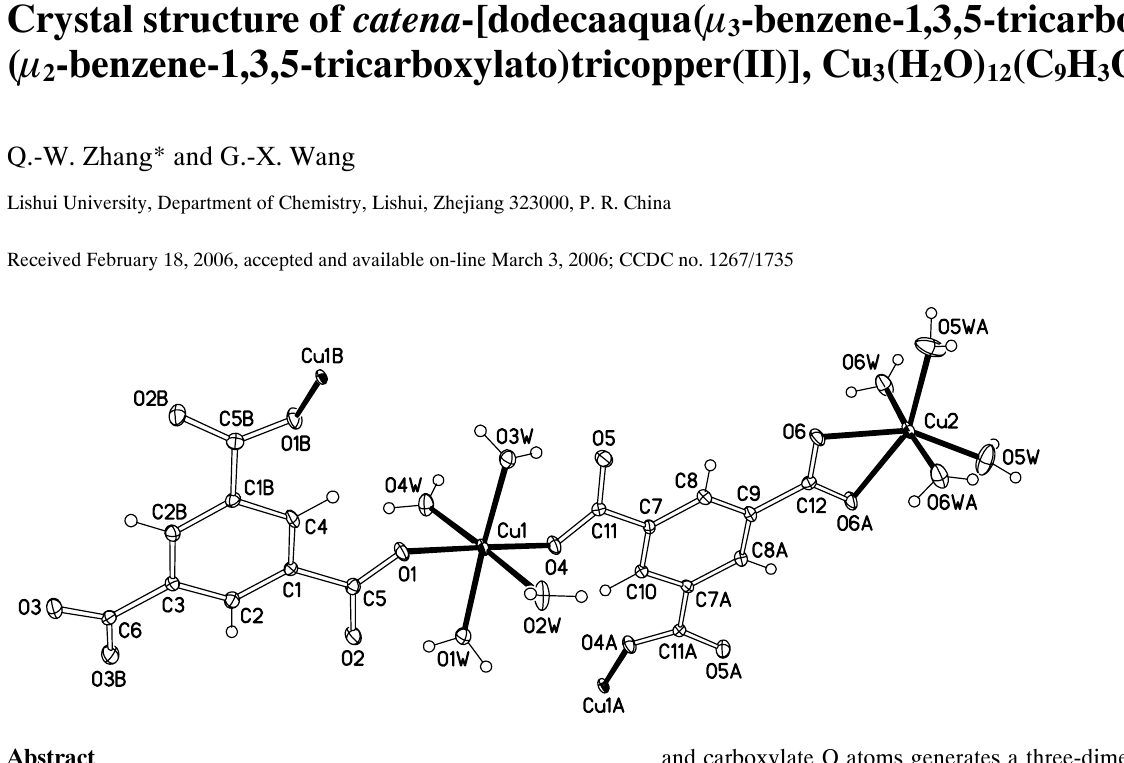
work. T he title structure is isostructur a l with the reported struc-